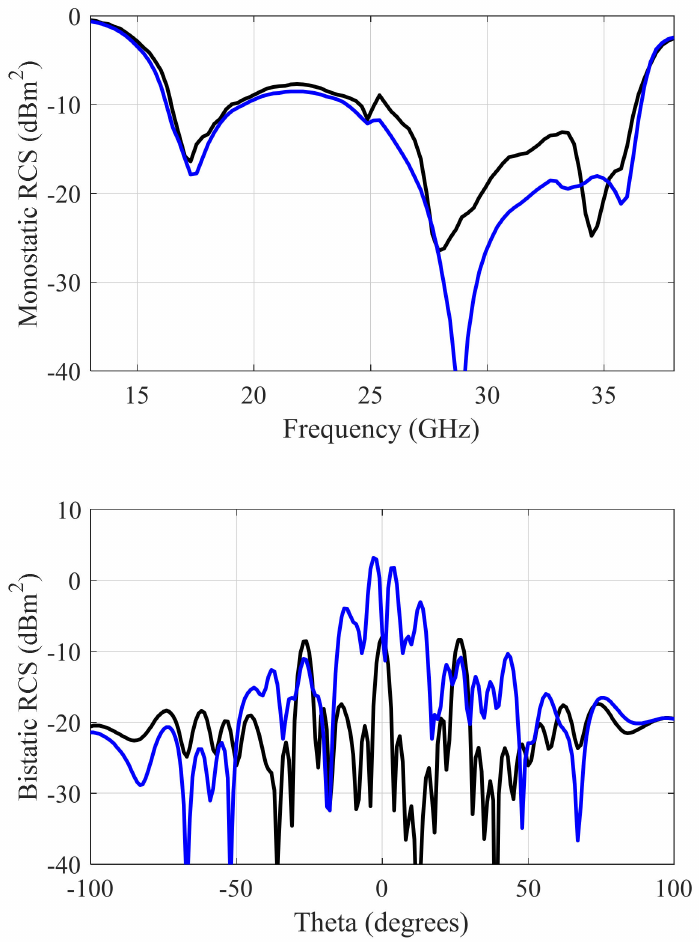
Figure 6. Monostatic ( top ) and bistatic at 28 GHz ( bottom ) RCS characteristics of the two metasur- faces. The bistatic RCS is evaluated at θ = 0 ◦ and ϕ = 0 ◦ . The monostatic performance is normalized to the reference PEC surface. The black and blue color corresponds to checkerboard and optimized metasurface performance,